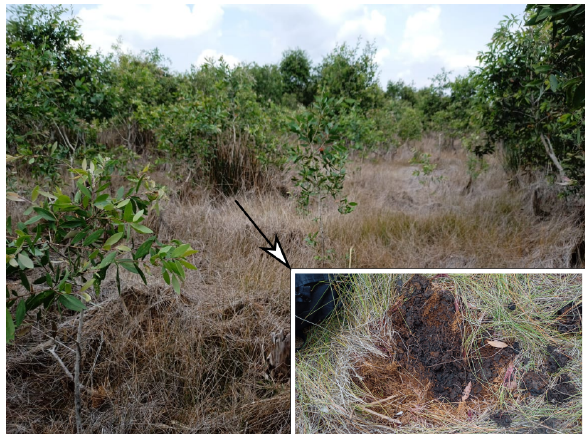
Figure 7. A picture of peat soils found in drainage peatlands, Landasan Ulin Selatan, Banjarbaru City, Indonesia.